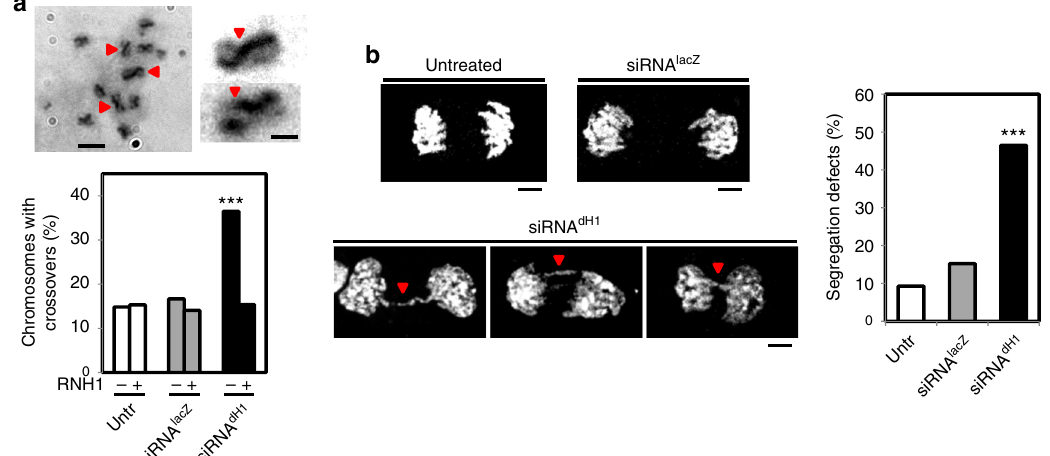
Fig. 3 dH1-depleted cells show a high frequency of SCE and chromosome segregation defects. a SCE-assay in siRNA dH1 cells. Sister chromatids are identi fi ed on the basis of their differential Giemsa staining due to their twofold difference in BrdU incorporation. Enlarged images of representative examples are shown on the right . Scale bars are 6 μ m and 3 μ m in the enlarged images. Red arrowheads indicate crossovers. On the bottom , the percentages of chromosomes with crossovers are presented for siRNA dH1 , siRNA lacZ and untreated cells expressing human RNH1 (+) or not ( − ) ( n > 100 for each condition). The p -values of siRNA dH1 respect to siRNA lacZ are indicated (no asterisk > 0.05, *** < 0.005; two-tailed Fisher ’ s exact F -test). b Anaphase fi gures for siRNA dH1 , siRNA lacZ and untreated cells stained with DAPI (in white ) are presented. Scale bars are 5 μ m. Red arrowheads indicate chromatin bridges. On the right , the percentages of mitoses showing segregation defects are presented for siRNA dH1 , siRNA lacZ and untreated cells ( n > 40 for each condition). The p -value of siRNA dH1 respect to siRNA lacZ is indicated (*** < 0.005; two-tailed Fisher ’ s exact F